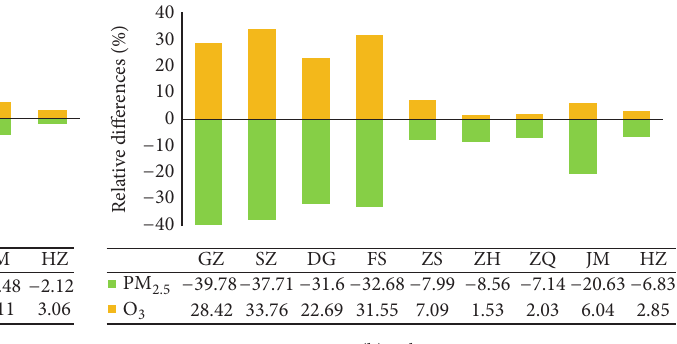
in PRD region for January and July increased by 0.24 ∘ C and 0.27 ∘ C, respectively, and nighttime tem- peratures increased more than daytime